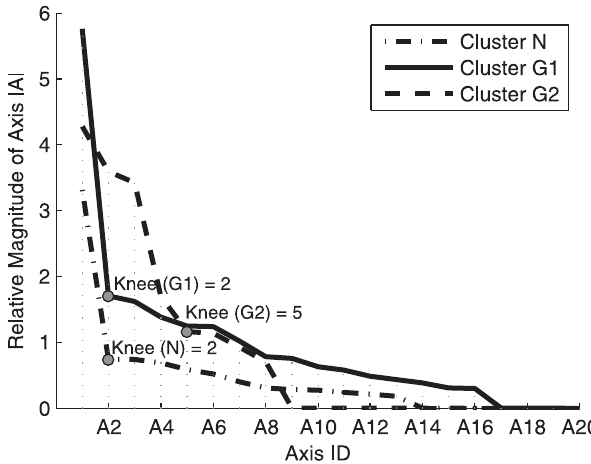
Figure 2. Plot of axis contribution of variational Bayesian independent component analysis mixture (VIM) (Y) versus number of axes (X). Axes beyond the knee point were removed, leaving 2 axes each for Clusters 1 and 2 and 5 axes for Cluster 3. The best VIM model was retrained 500 times, constrained to the reduced number of